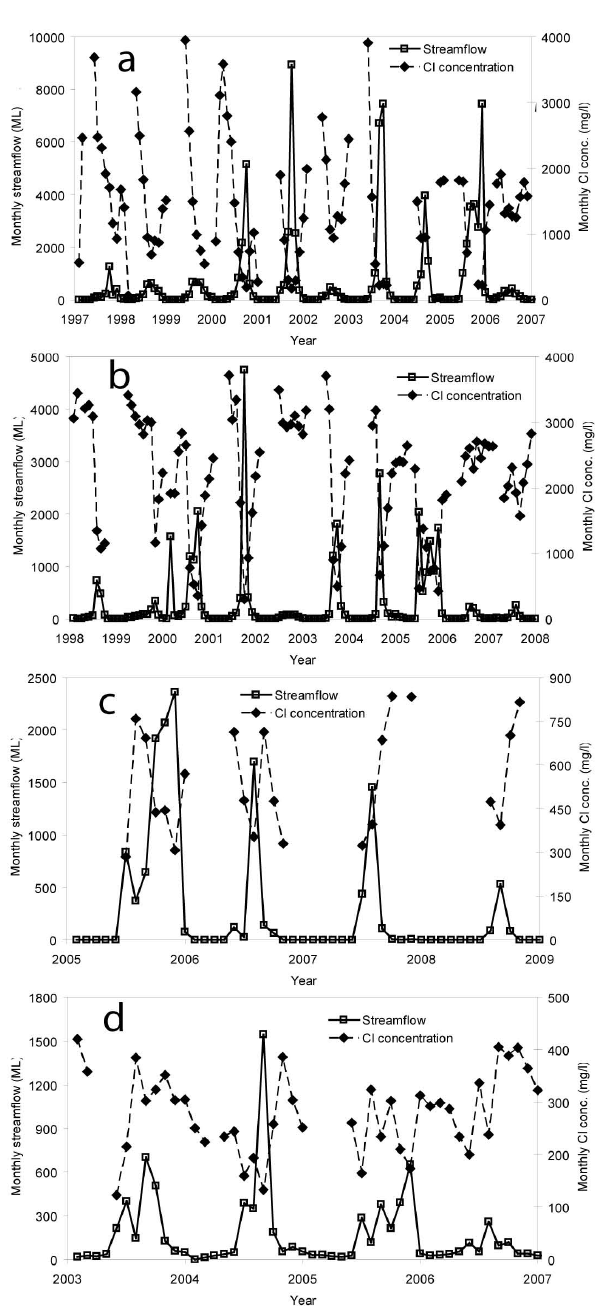
Fig. 6. Monthly series of streamflow and water-weighted aver- age monthly chloride concentration in stream water for four se- lected catchments: (a) North Para River catchment with gauge ID 5050533, (b) Bremer catchment with gauge ID 4260688, (c) Bremer catchment with gauge ID 4261070, and (d) Onkaparinga at Hahndorf catchment with gauge ID 5030537.